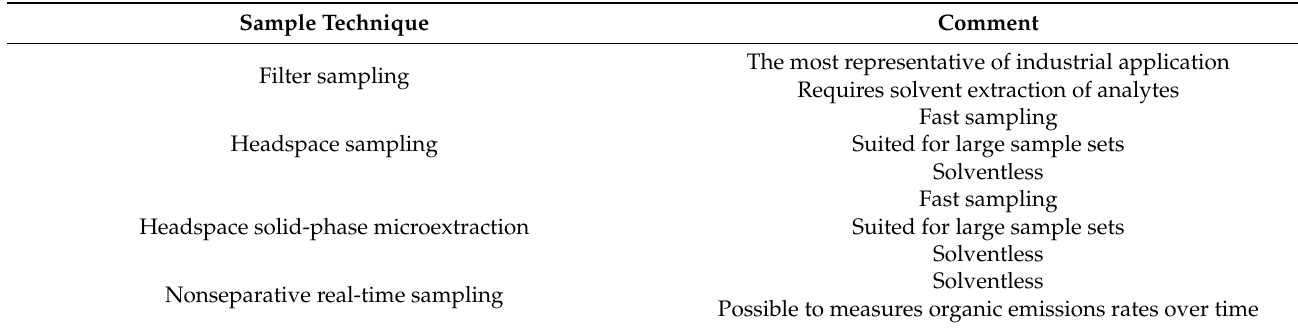
Table 2. Comparison of sample preparation techniques.